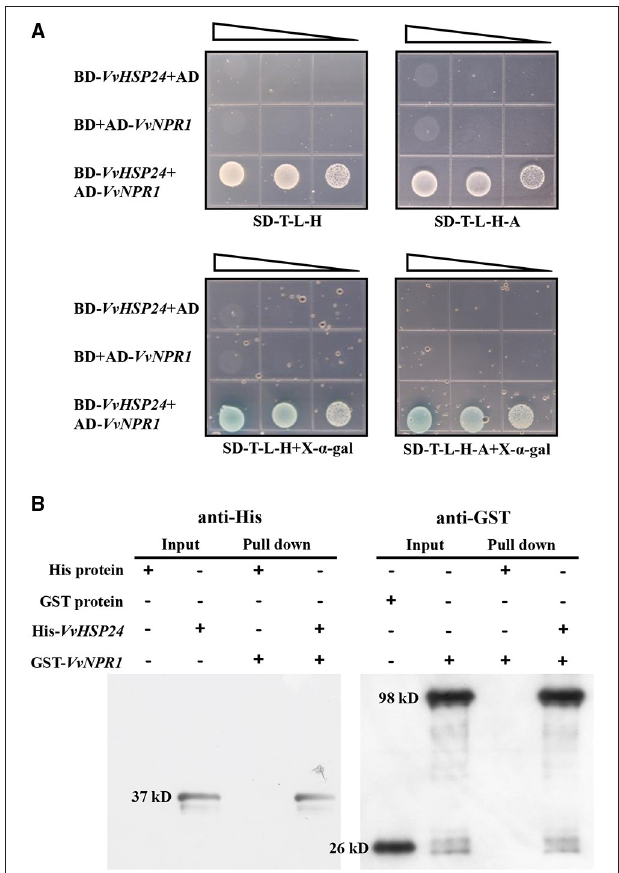
FIGURE 5 | VvHSP24 interacts with VvNPR1 in vivo and in vitro . (A) Yeast two-hybrid analysis of the physical interaction between VvHSP24 and VvNPR1 . SD-T-L-H, SD/-Trp-Leu-His agar medium; SD-T-L-H-A, SD/-Trp-Leu-His-Ade agar medium. The right-angled triangles on the top of the gridded Petri dishes represent the absorbance of yeasts at 600nm in a 10-fold dilution series, from 1 to 10 − 2 abs. (B) The GST-fused VvNPR1 protein (1mL) was incubated with 1mL of preimmobilized His- VvHSP24 protein in a total volume of 25mL at 4 ◦ C for more than 8h. The pulled down proteins (6 µ L) were analyzed by western blotting with anti-His or anti-GST